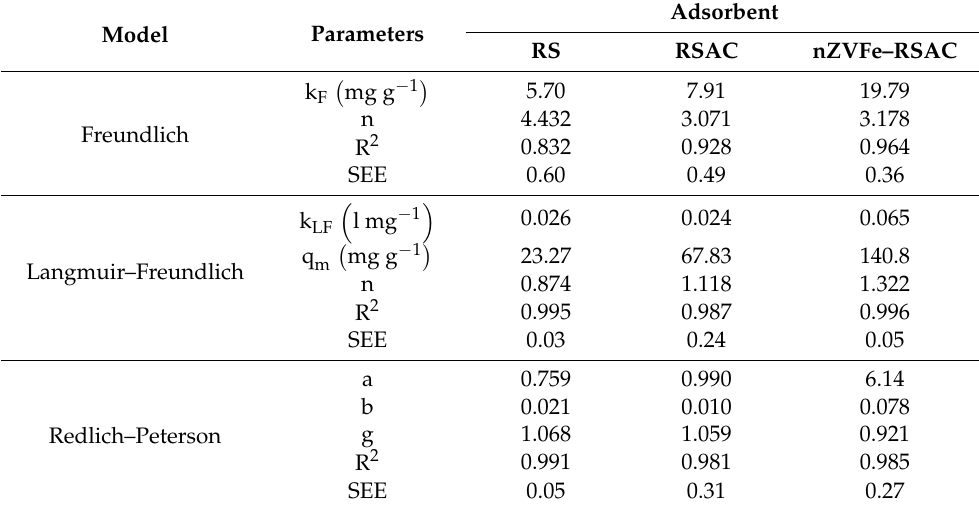
− 33.16 Figure 12. Temperature effect on sorption coefficients ( k (cid:2914) ) for Pb(II) adsorption by RS, RSAC, and nZVFe–RSAC 3.7. Effect of Competing Ions